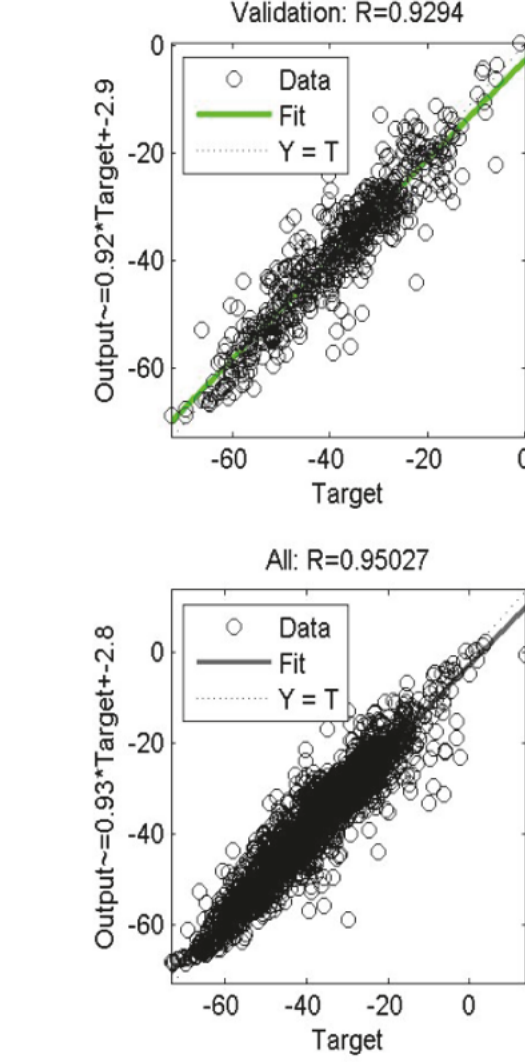
Figure 7: Performance (regression) of ANN model for prediction of Bouguer anomalies around Benue trough with 2 inputs.